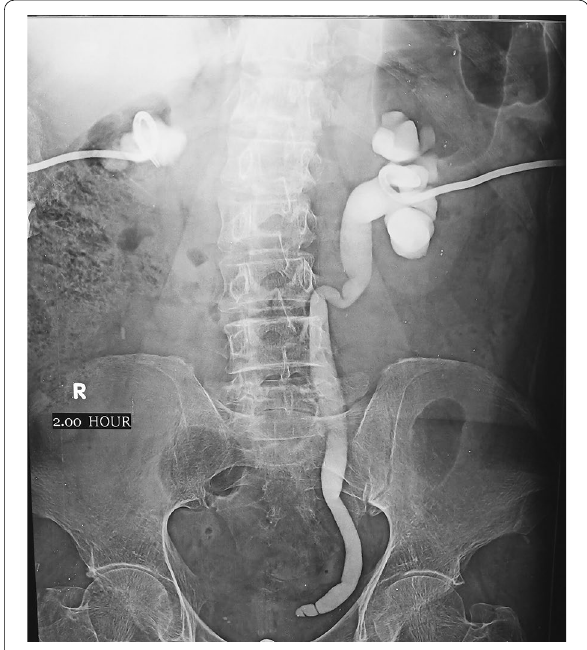
Fig. 3 Bilateral nephrostogram showing Rt pelvic junction obstruction and left vesicoureteric junction obstruction with no evidence of contrast in the